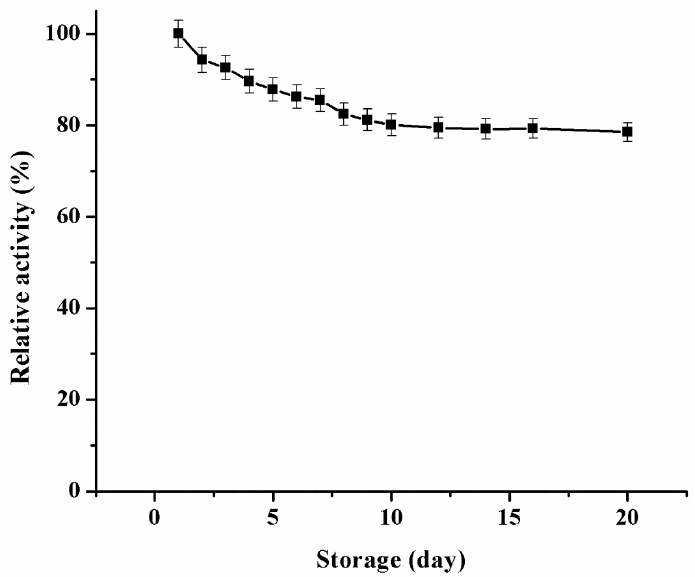
Figure 9. Storage stability of immobilized lipase in resolution reaction. (Reaction conditions: 0.02 g immobilized BCL, 45 °C, 1 h).